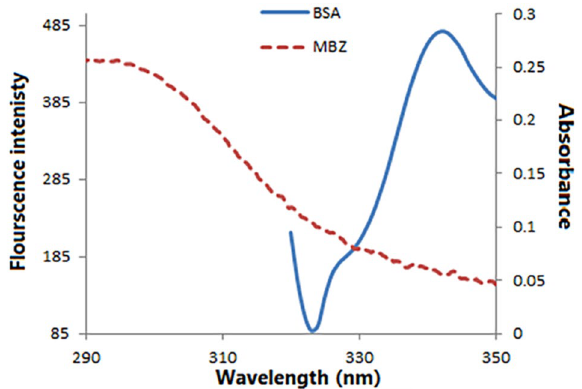
Figure 11. Spectral overlap between the BSA fluorescence emission spectrum (40 µM) and the absorption spectrum of MBZ (15 µM) at 298 K and pH